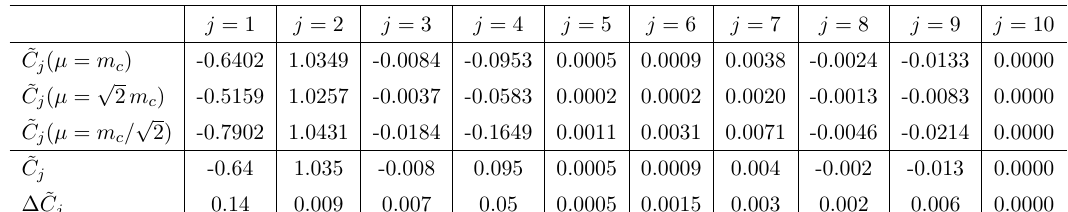
˜ C j for j ∈ [1 , 10] up to NNLO accuracy. In the first three rows we and for scale variations of µ = c